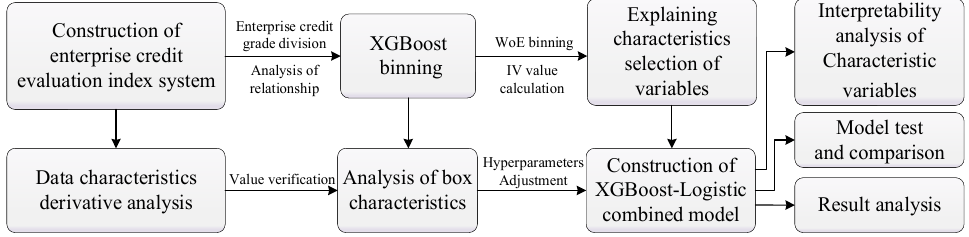
Figure 1. Mechanism of the dynamic comprehensive evaluation of corporate credit.